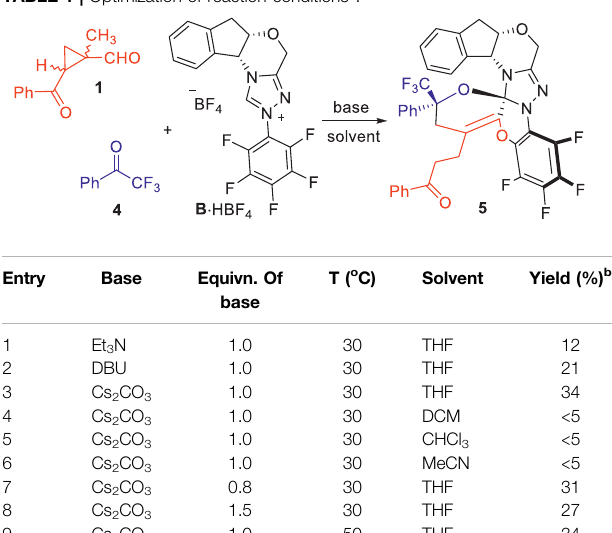
TABLE 1 | Optimization of reaction conditions a